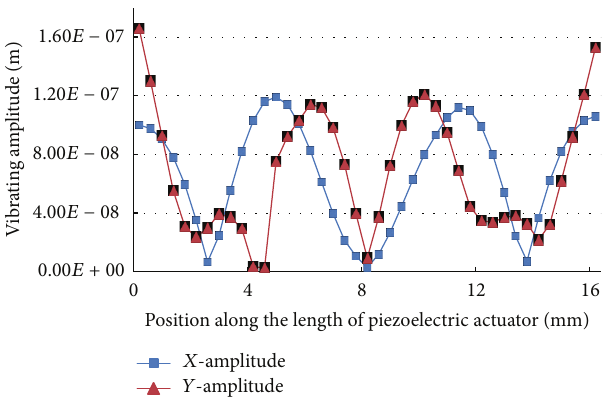
Figure 5: The vibrating amplitudes in the 𝑋 -direction and the 𝑌 - direction along the length of piezoelectric